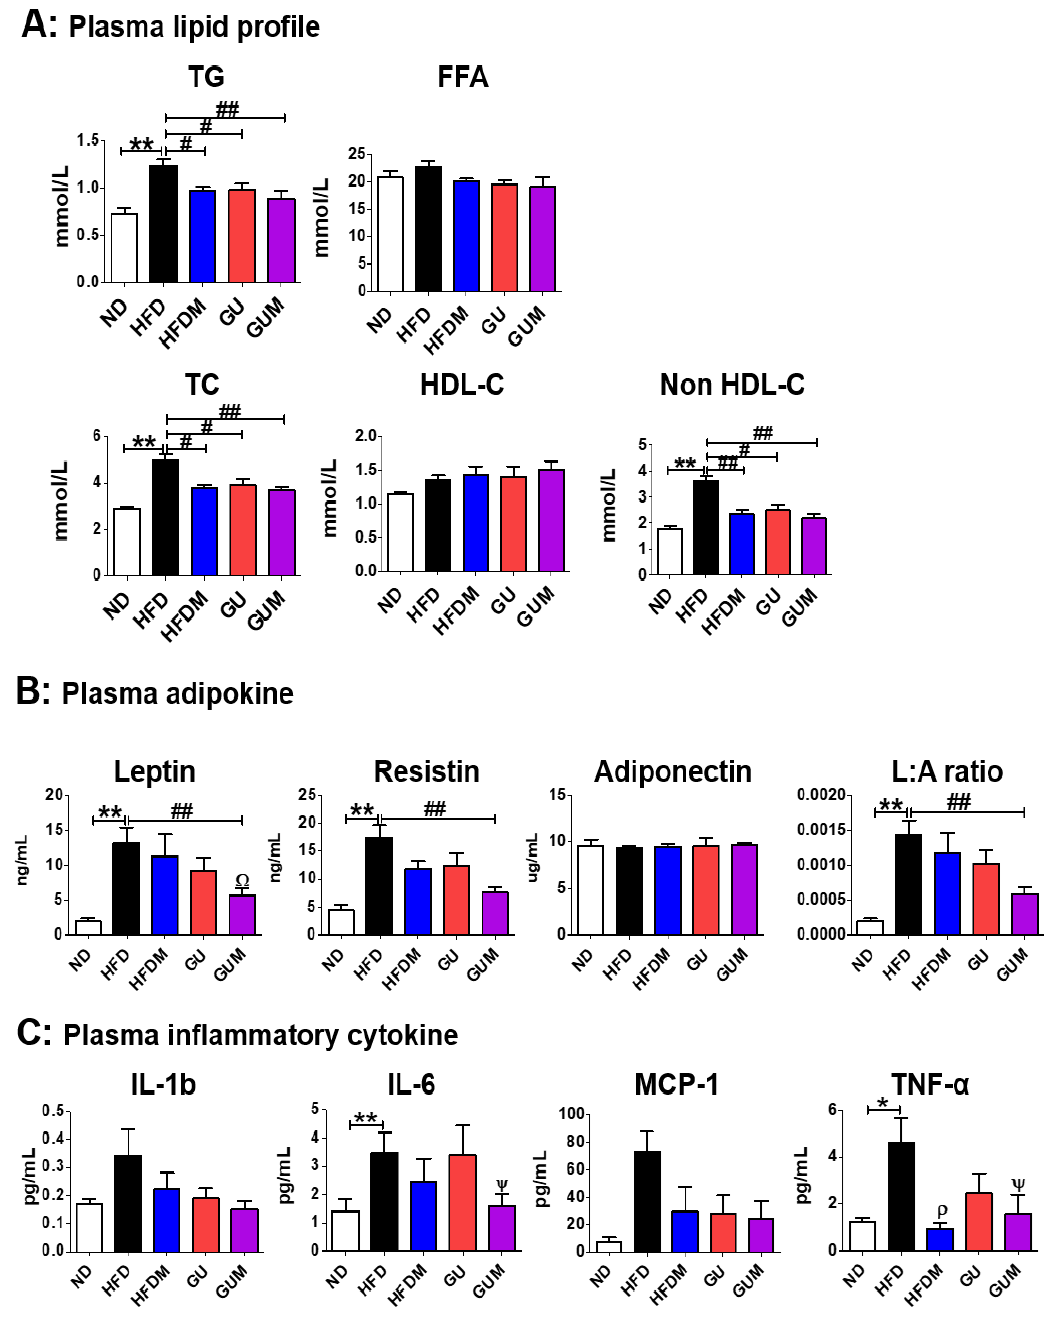
Figure 3. Effect of metformin, G. uralensis Fischer, and their combination after 16 weeks on plasma lipid profile ( A ); adipokine concentrations ( B ); and inflammatory cytokine levels ( C ) in C57BL/6J mice fed a high-fat diet. Data are presented as the mean ± SEM. Significant differences between HFD and ND groups are indicated: * p < 0.5, ** p < 0.01. Significant differences among the high-fat diet groups are indicated: # p < 0.05, ## p < 0.01. When compared one-to-one, there were significant differences between the GUM and HFD groups: Ψ p < 0.05. When compared one-to-one, there were significant differences between GUM and HFDM : Ω p < 0.05. When compared one-to-one, there were significant differences between HFDM and HFD: ρ p < 0.05 . ND, normal diet (AIN-93G 16 kcal% fat); HFD, high-fat diet (60 kcal% fat); HFDM, HFD + metformin 50 mg/kg; GU ( G. uralensis Fischer), HFD + GU 0.015%; GUM, HFD + GU 0.015% + metformin 50 mg/kg .